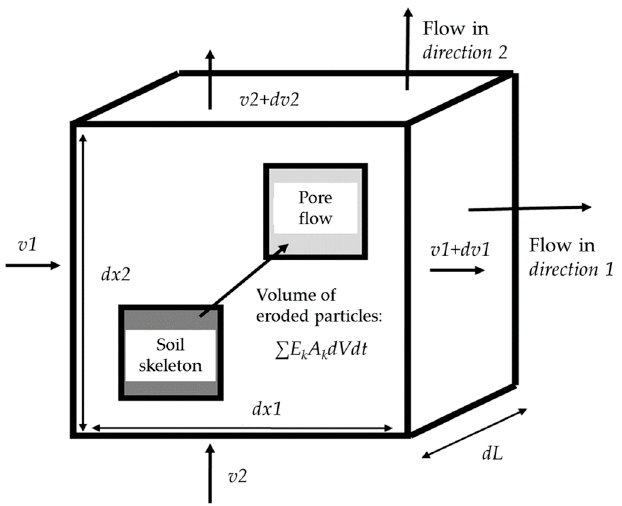
Figure 1. Unit volume of seepage field as the modeling framework.